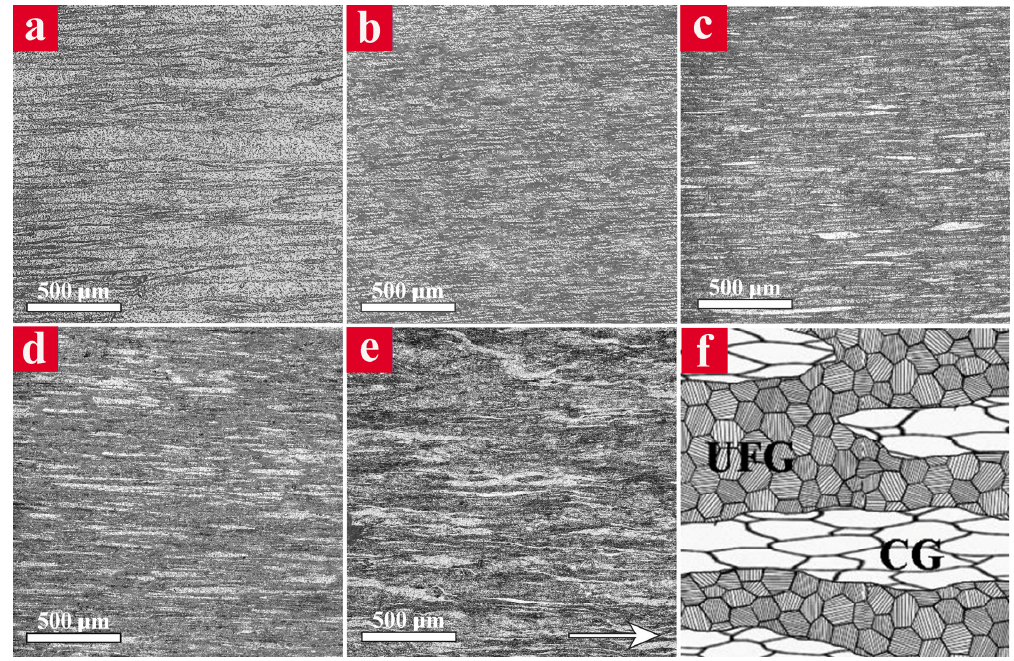
Figure 1. Optical microscopy (OM) micrographs of the Al6063 specimens prepared through mechanical milling followed by hot extrusion: ( a ) plain coarse-grained (CG); ( b ) plain ultrafine-grained (UFG); ( c ) 15 vol. % CG bimodal; ( d ) 30 vol. % CG bimodal; ( e ) 45 vol. % CG bimodal and ( f ) schematic illustration of the bimodal microstructure.